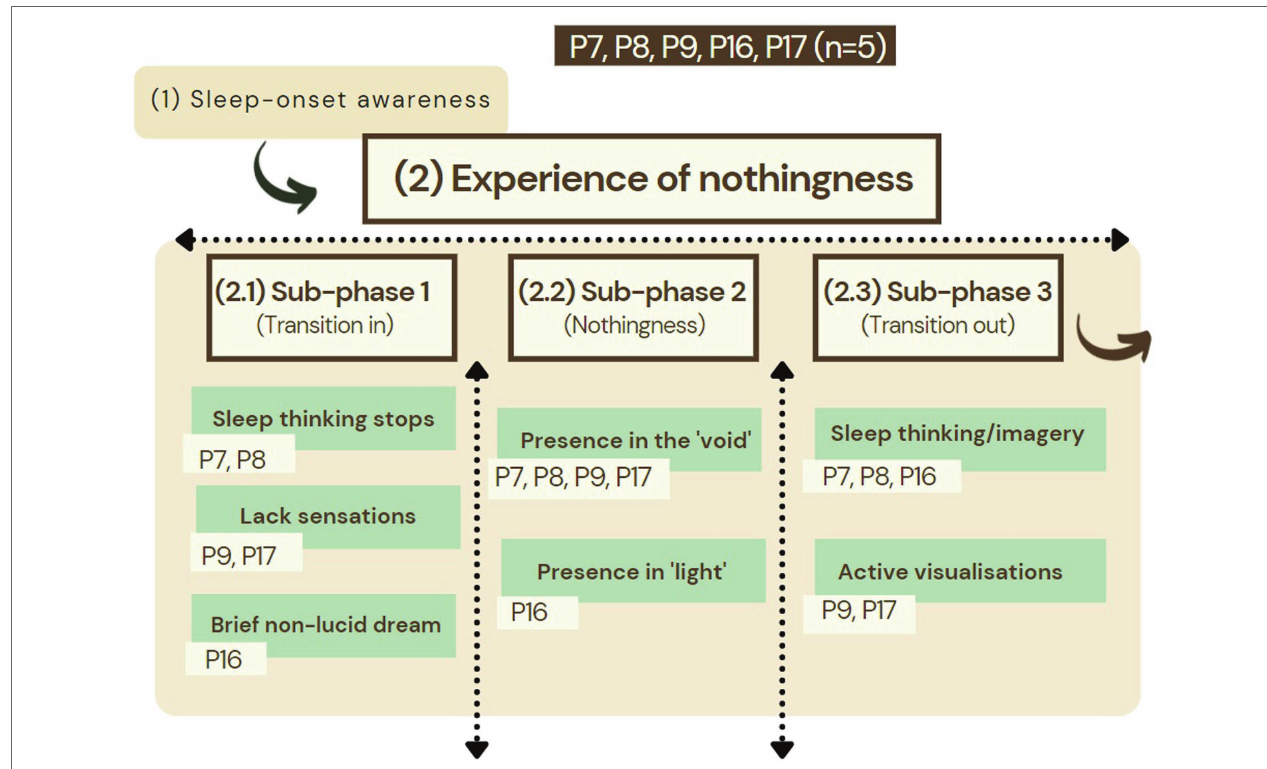
FIGURE 3 | Diachronic structure 2 was characterized by a transition into the void or nothingness without a preceding lucid dream dissolution in participants P7, P8, P9, P16, and P17 ( n = 5). Instead, for these participants there was an awareness of their sleep onset and perception of brief hypnagogic/dreaming imagery, noticing their thoughts stopping, or the absence of bodily